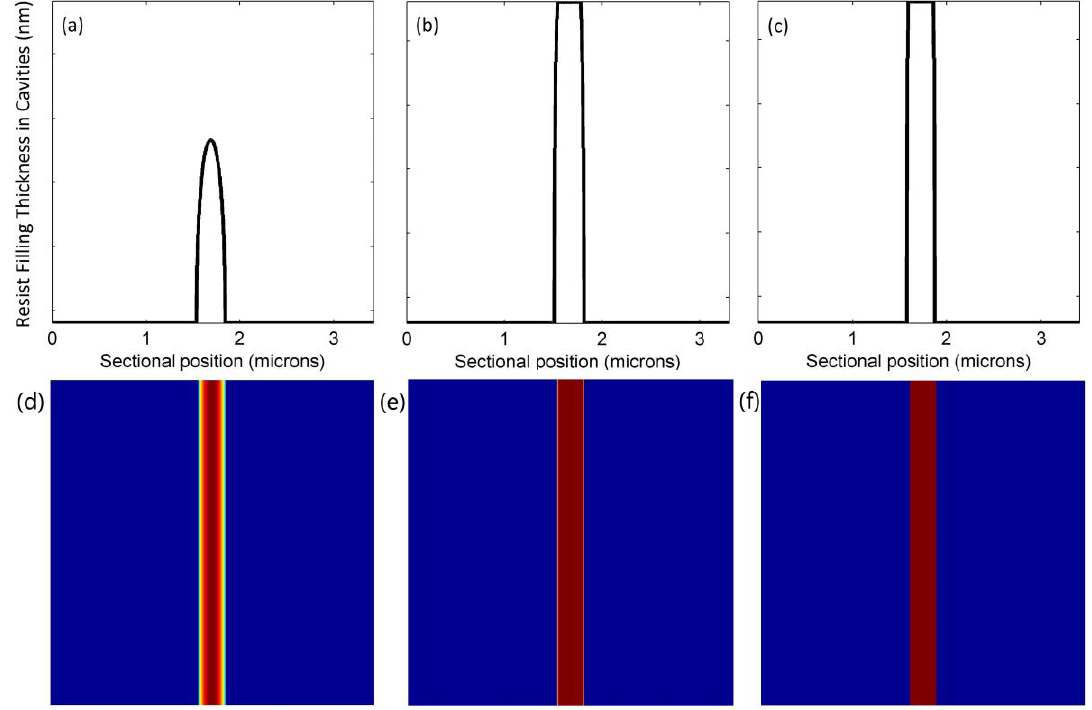
Figure 5. Profiles of resist filling in the nanoscale cavity at ( a ) 1.08 s; ( b ) 4.32 s; ( c ) 10.80 s and their corresponding top views at ( d ) 1.08 s; ( e ) 4.32 s; ( f ) 10.80 s.